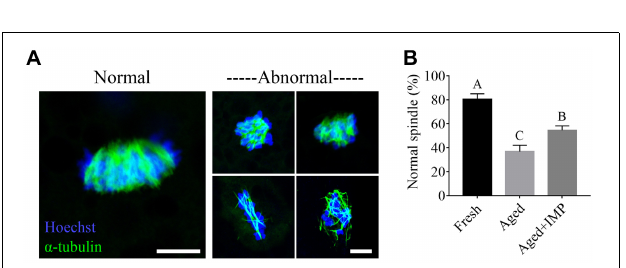
FIGURE 7 | Effect of IMP supplementation on the spindle assembly in porcine aged oocytes. (A) Representative immunofluorescent images of normal/abnormal spindle morphologies and chromosome alignment in aged and IMP-treated aged porcine oocyte. Scale bar = 5 µ m. (B) The rate of normal/abnormal spindle morphologies and chromosome alignment in fresh, aged, and IMP-treated aged porcine oocyte. Compared with aged oocytes ( N = 114), the rate of normal spindle formation was significantly increased with IMP treatment ( N = 115). However, it is still lower than that in the fresh oocytes ( N = 127). Significant differences are represented with different capital letters ( P < 0.01).